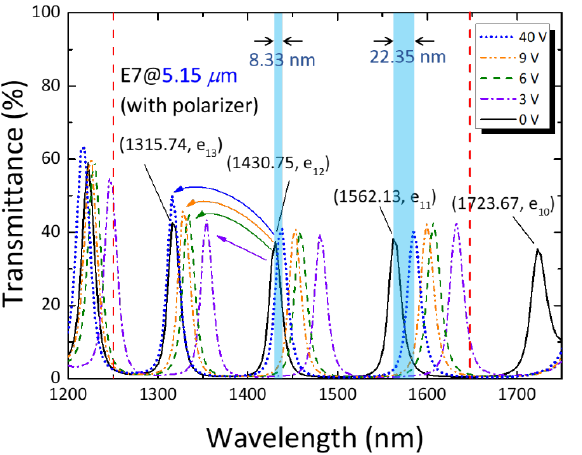
Figure 5. Polarized transmission spectra of the 1D PC/LC cell of d = 5.15 μm at various voltages.